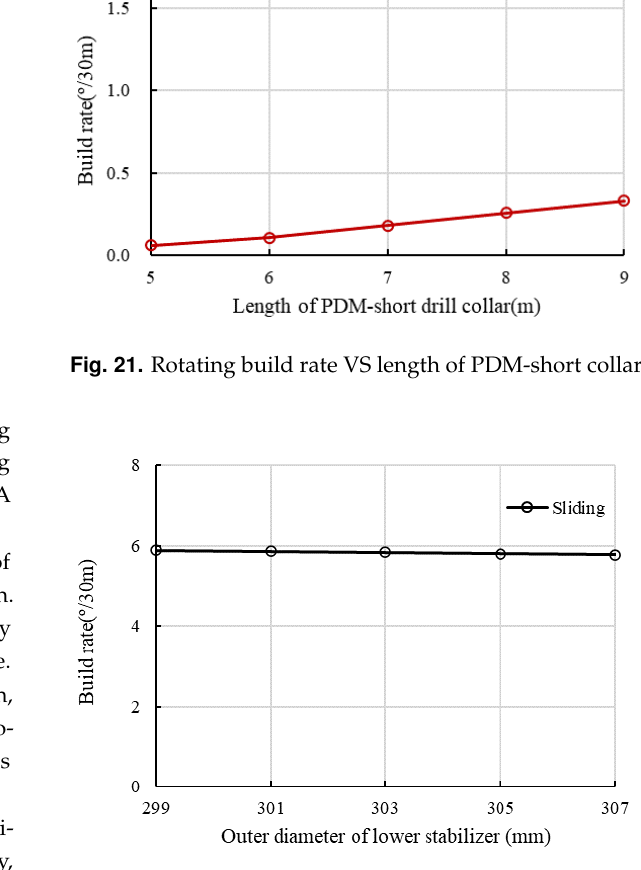
Fig. 22. Sliding build rate VS outer diameter of lower